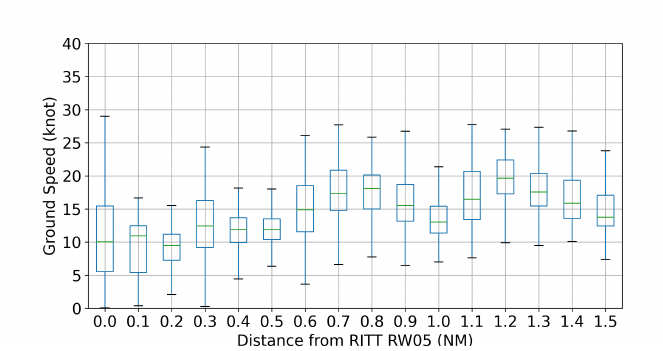
Figure 4. GS distribution of departures from T1.